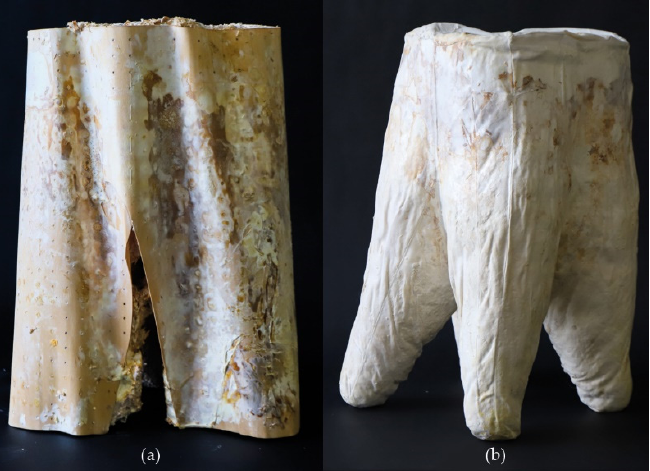
Figure 1. Mycelium-based prototypes: ( a ) using a timber veneer mold, and ( b ) using cotton fabric mold, by F. Milano, K. Antorveza, L. Kiesewetter, G. Lochnicki, Materials Matter Lab IV, 2020.